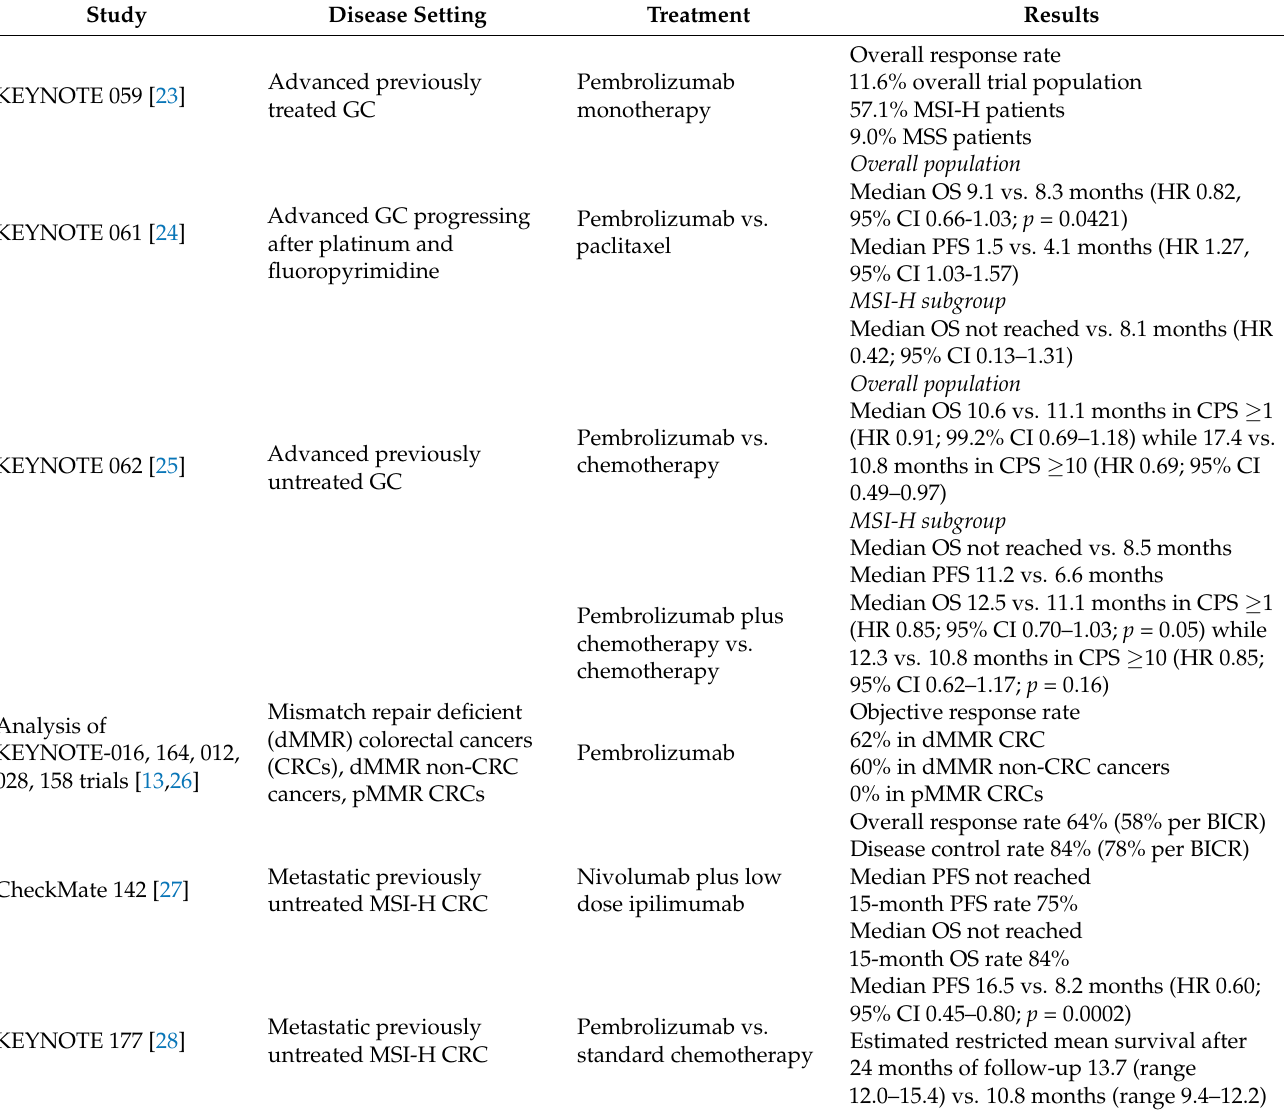
Table 4. Literature-based evidence on immunotherapy in MSI-H